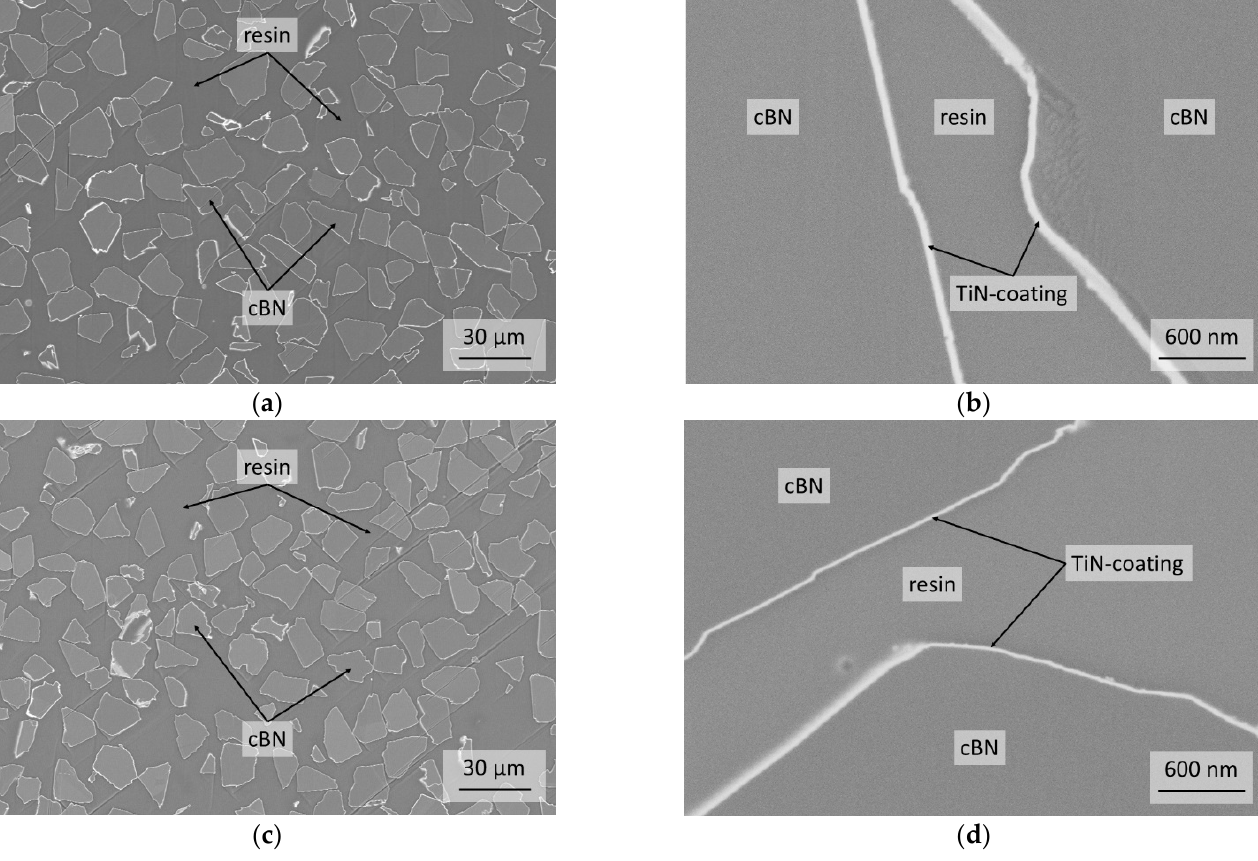
Figure 4. Cross-sections via FESEM (material contrast) of the ( a , b ) TiN-coated BT and ( c , d ) BTV powder.